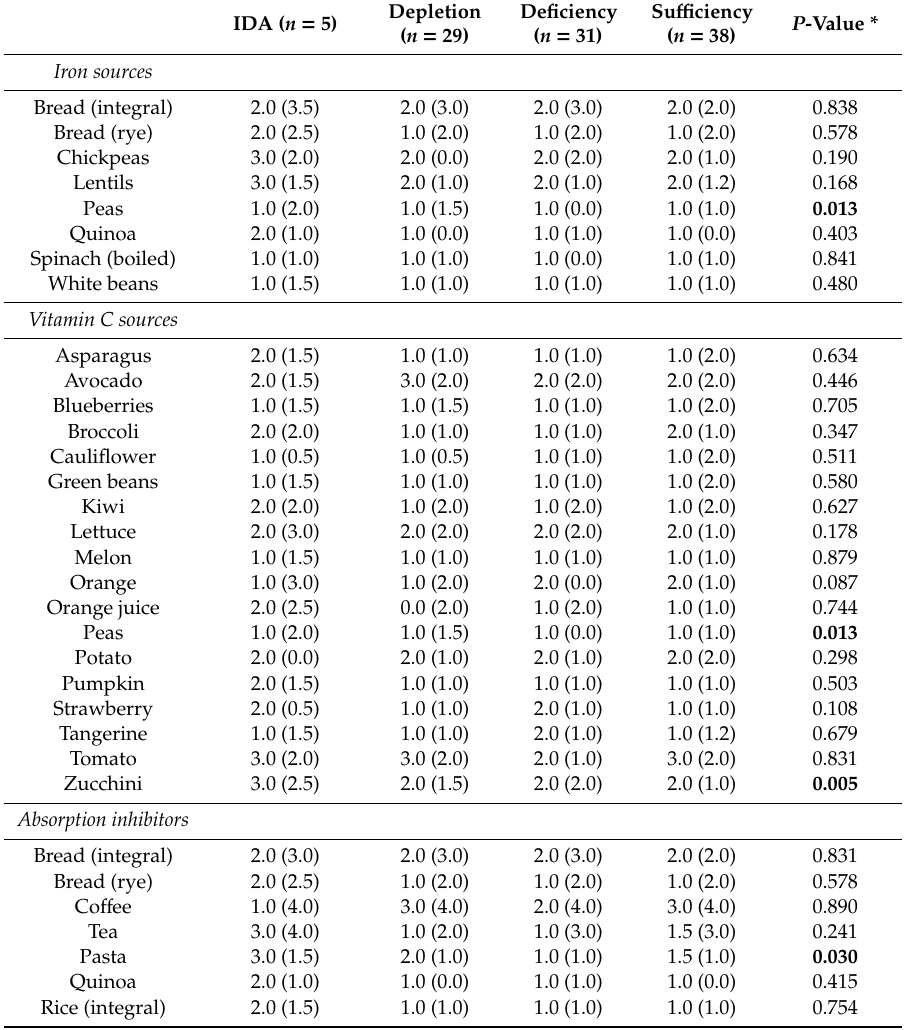
Table 5. The dietary patterns in relation to iron